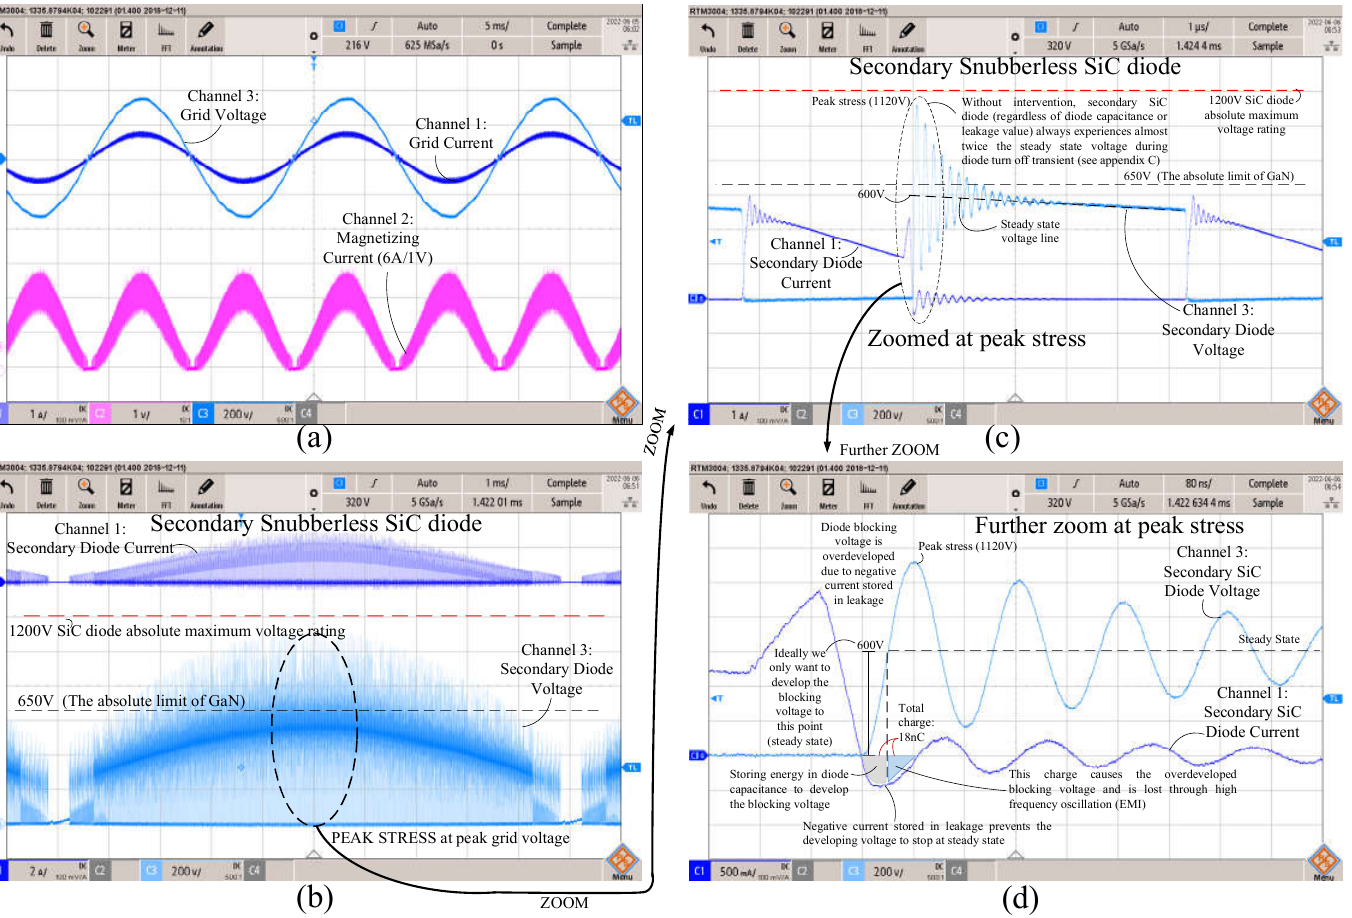
Figure 2. Experimental result on grid-connected flyback inverter demonstrating the secondary SiC diode issue ( a ) grid current and grid voltage ( b ) rectifier waveform in a half grid cycle ( c ) zoomed at peak grid voltage ( d ) further zoom. Parameters of flyback inverter: grid voltage v g = 240 V rms (340 V peak ), v pv = 37 V, turn ratio N p :N s = 1:6, magnetizing inductance L m = 22 uH, secondary referred leakage L s = 10 uH.